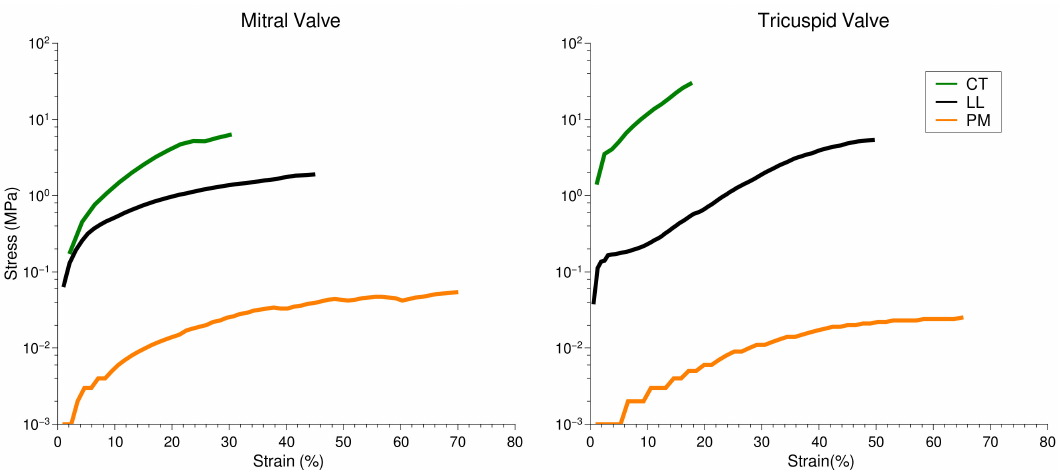
Figure 4. Stress vs. strain evaluation of individual sample elements from MV and TV samples tri-sected so as to measure pure tissue sub-types